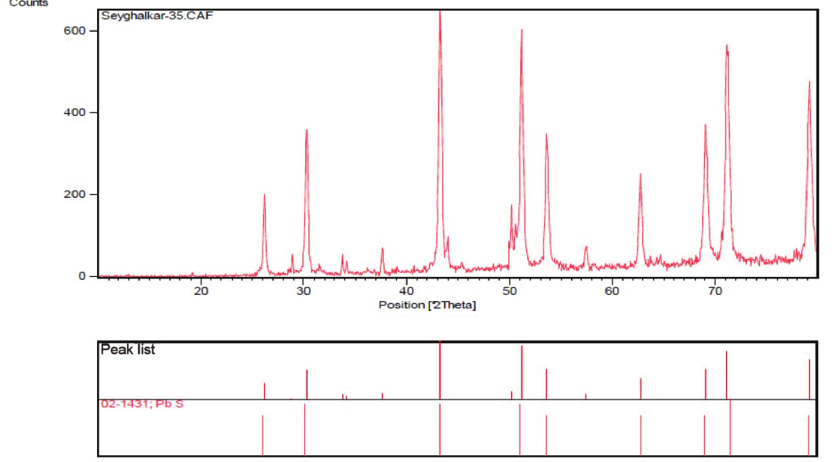
Figure 1: XRD pattern of sample no.